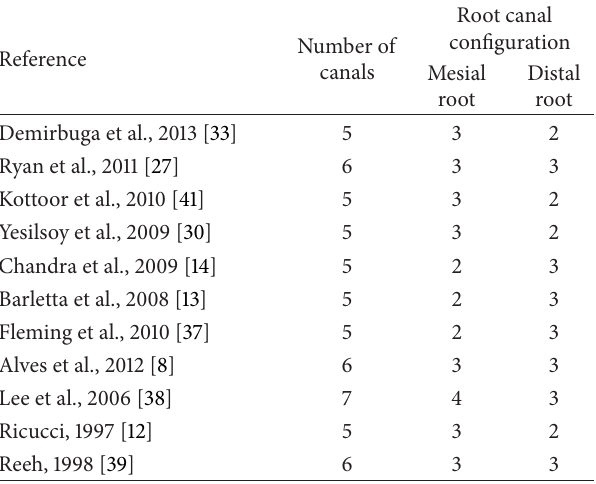
Table 1: Case reports on mandibular first